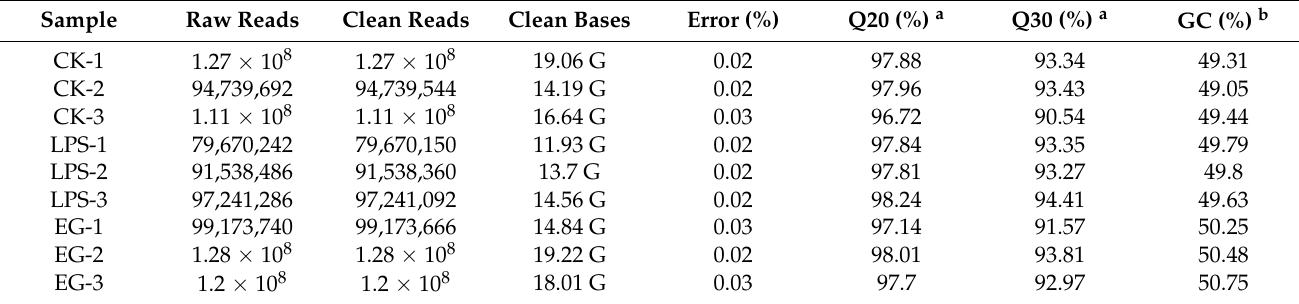
Table 2. Sample-data